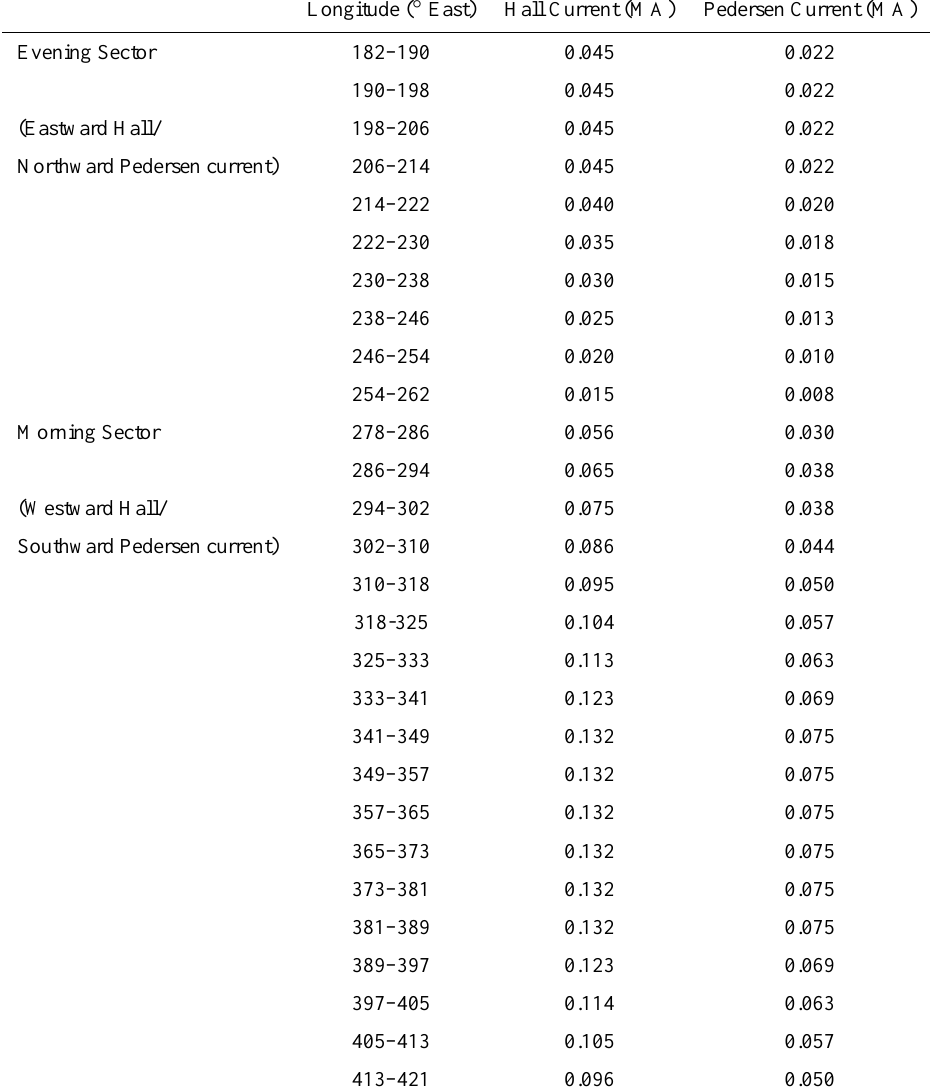
Table 1. Current magnitudes for Pre-onset model.